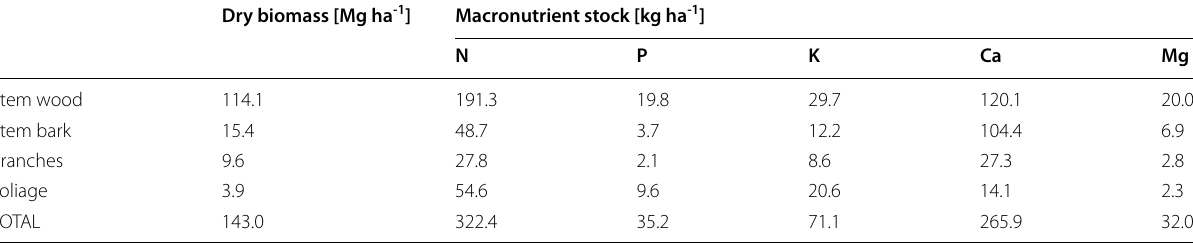
Table 1 Dry biomass and macronutrient content of the pre‑harvest 102‑year‑old Scots pine